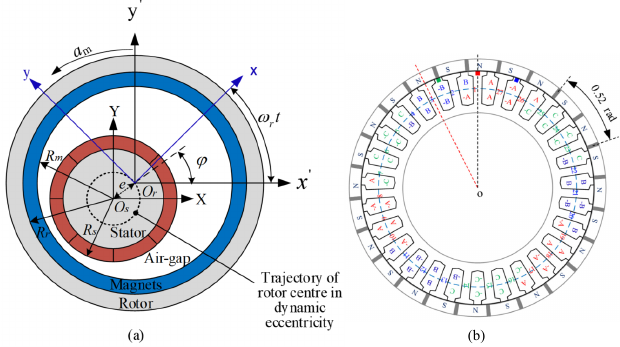
Figure 1. Hub-driven electric vehicle model.